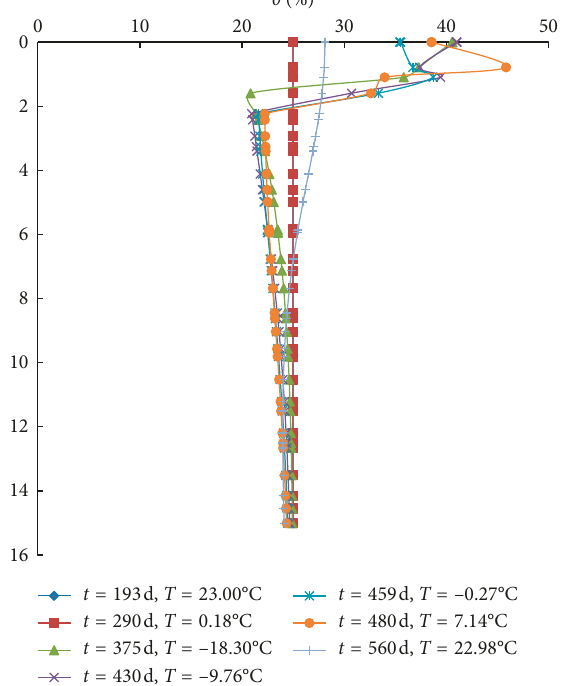
Figure 10: Moisture distribution of the slope waist along vertical distance from slope surface at different times.